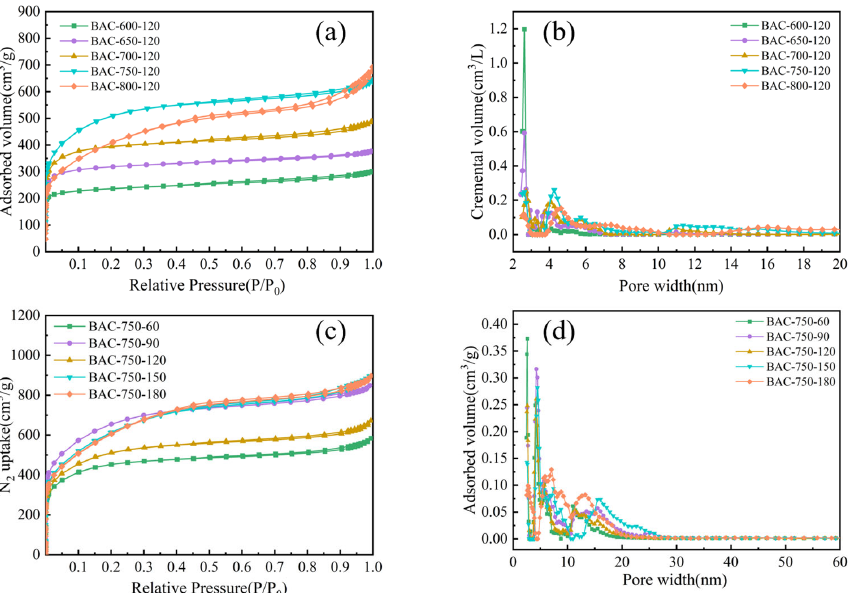
Figure 2. Pore characteristics of the BACs. ( a , c ) N 2 adsorption/desorption isotherms; ( b , d ) pore-size distribution curves. Table 1. Surface areas and porosities of the